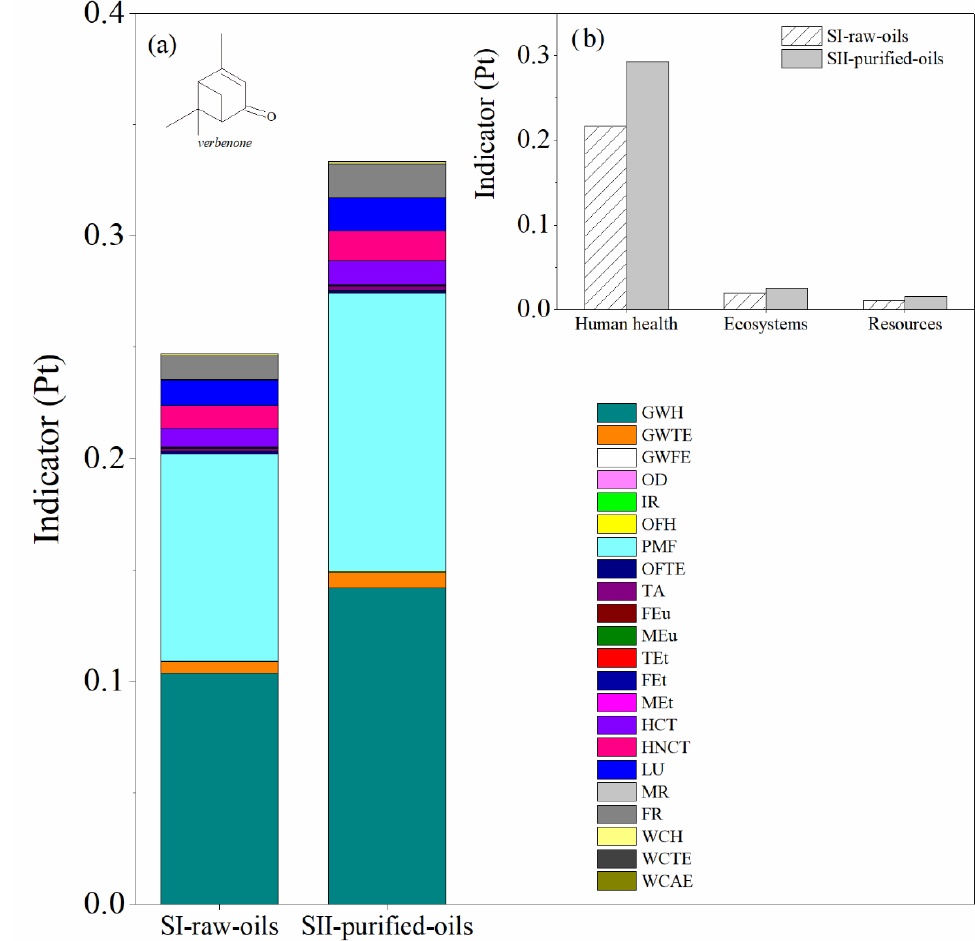
Figure 8. Comparison of the environmental impacts in the SI-raw-oils and SII-purified-oils scenarios for the verbenone process production. ( a ) Impact categories and ( b ) damage categories. Assessment method: ReCiPe 2016 Endpoint (H) V1.04/World (2010) H/A.